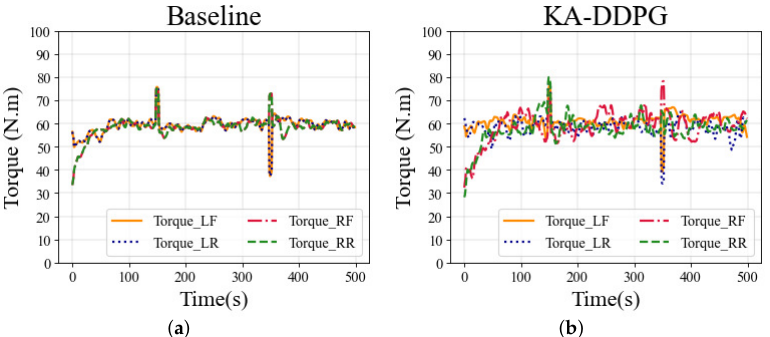
Figure 11. Torque distributions in the cornering scenario: ( a ) baseline and ( b )